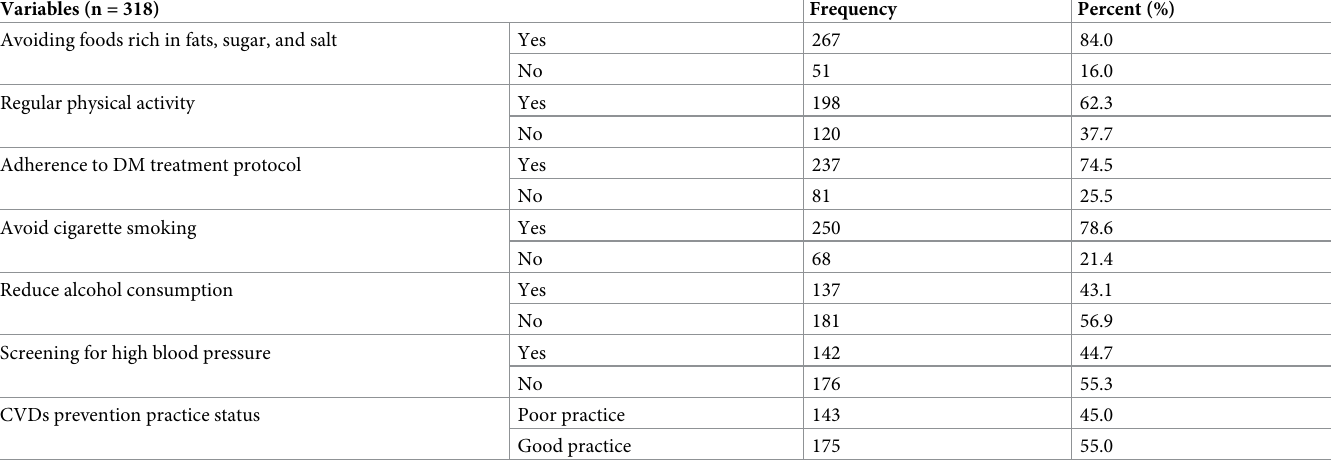
Table 3. Primary prevention practices of cardiovascular diseases among diabetes mellitus patients who were on follow-up at Jimma University Medical Centre, 2021. Variables (n = 318) Frequency Percent (%) Avoiding foods rich in fats, sugar, and